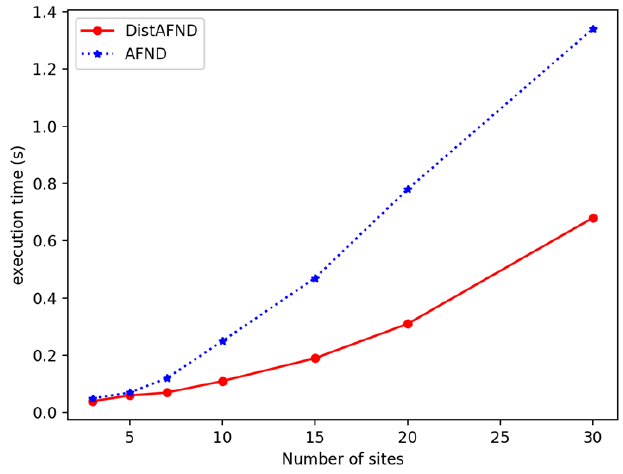
Figure 4. Execution time by number of sites Comparison of execution times based on sample size by sites